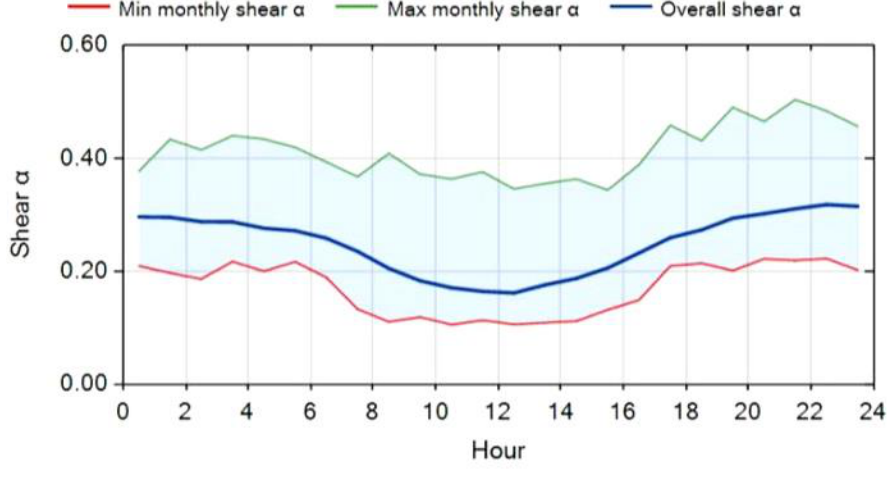
Figure 9. Maximum, minimum and average monthly wind shear The blue line presents the average wind shear between the maximum α and the minimum α. The average is calculated to eliminate the uncertainty as much as